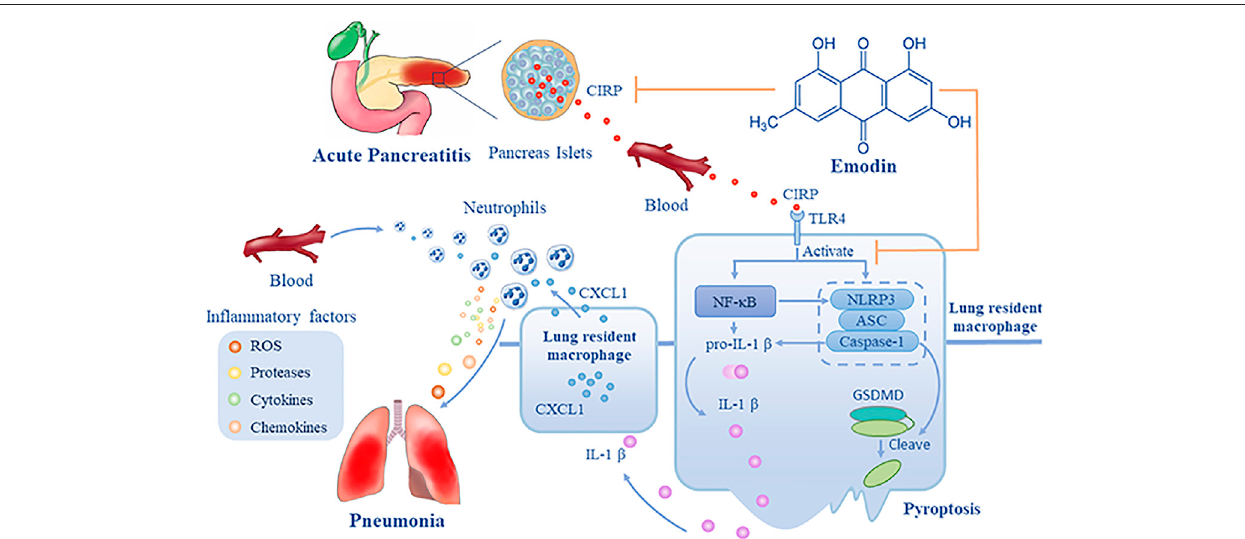
FIGURE7| Adiagram illustratesthepotentialmechanismsunderlying theaction ofemodinininhibitingSAP-ALI.DuringtheprocessofSAP,CIRPisreleasedfrom pancreatic islets into the blood and circulates into the lung, leading to the activation of the NF- κ B signaling and NLRP3 in fl ammasome formation and pyroptosis of lung resident macrophages that release IL-1 β . Subsequently, IL-1 β induces CXCL1 expression in macrophages and others, and the increased CXCL1 recruits neutrophil in fi ltrationintothelung,wherethein fi ltratedneutrophilsproduceROS,proteases,cytokines,andchemokines,damagingthelungtissues.EmodinmayinhibitCIRP expression and the CIRP-related NF-kB signaling and NLRP3 in fl ammasome formation, IL-1 β , and CXCL1 expression, mitigating neutrophil in fi ltration and lung damages, alleviating SAP-ALI. Hence, emodin targets the CIRP/NLRP3/IL-1 β /CXCL1 pathway, the critical players in the pathogenesis of SAP-ALI, and may be a promising candidate for intervention of